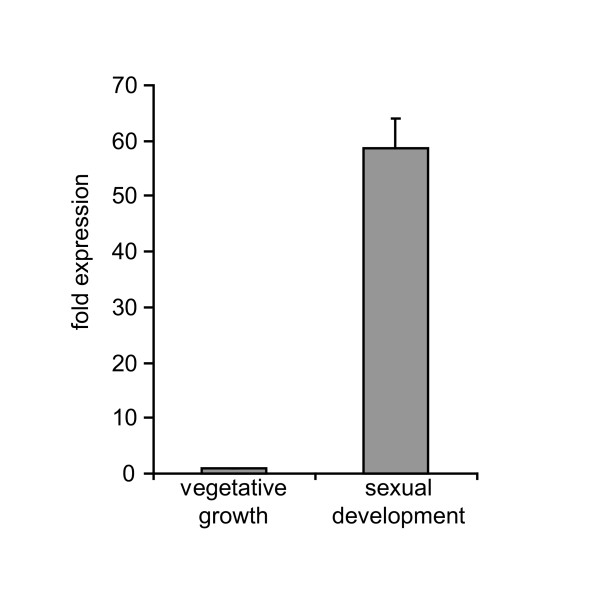
Transcript levels of tap1 are upregulated during sexual development. tap1 transcript levels in the wild type under conditions of vegetative and sexual development were analyzed by real time PCR. For normalization, transcript levels of the SSUrRNAs were used as described previously [3]. Expression is given as fold induction (mean of two independent experiments, error bars indicate standard deviation) with transcript levels during vegetative growth set to 1. Real time PCR results were tested for significance of differential expression at a level of p = 0.001 using REST [24].